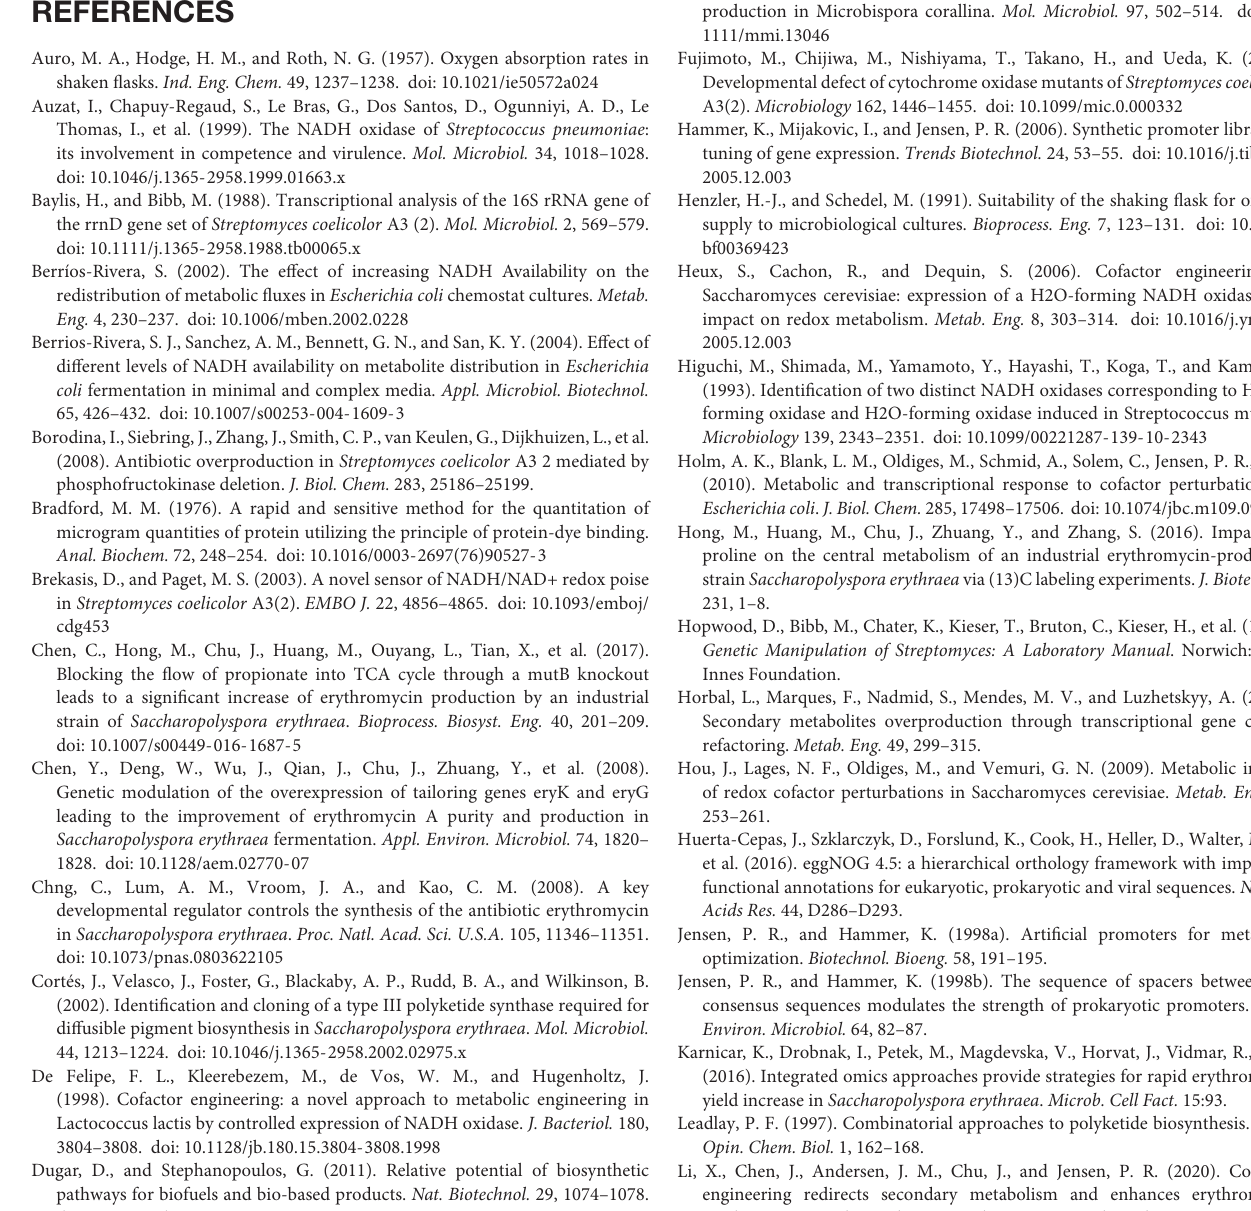
FIGURE S2 | Coding sequence of NADH oxidase after codon optimization. FIGURE S3 | Concentration of residual glucose for E3 and E3:F1F0ATPase (E3H) in 1 L fermenters with 600 mL minimal liquid medium. TABLE S1 | Sequences of promoters. TABLE S2 | Differentially expressed genes in A2N relative to E3. TABLE S3 | Genes with descending tendency at the transcription level in E3, A2N, and